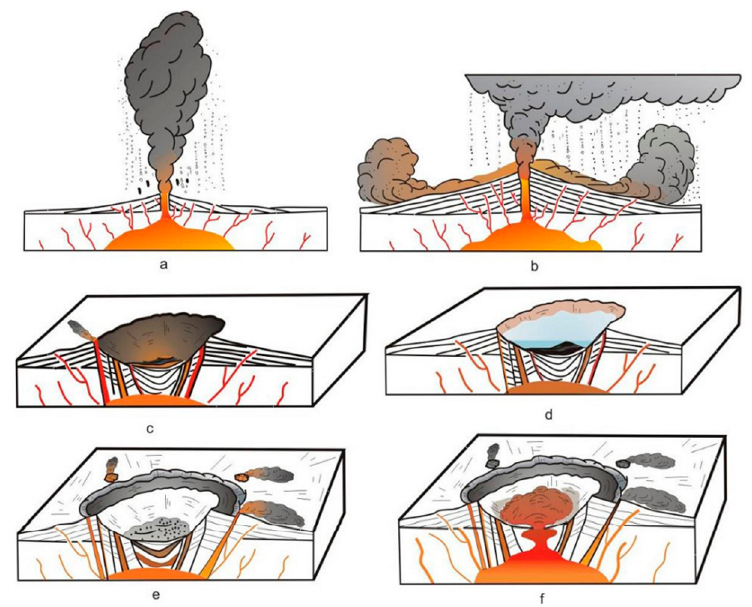
Figure 2. Schematic diagram of the evolution of the Shenxianju Caldera. ( a ) Initial Britney eruption stage of the caldera, forming the falling accumulation facies; ( b ) Large-scale explosion stage, forming the pumice flow due to the collapse of eruption column; ( c ) The magma chamber is evacuated, and the caldera collapses to form caldera depression; ( d ) Caldera lake formed and began to receive sediments; ( e ) The overall collapse of Caldera, the outer ring fracture formed, the caldera revived, and the side crater began to erupt; ( f ) The central high-level magma chamber intrudes upward, forming the central intrusion. At the same time, an intrusion dome formed above the side crater, blocking the passage and terminating the volcanic activity.